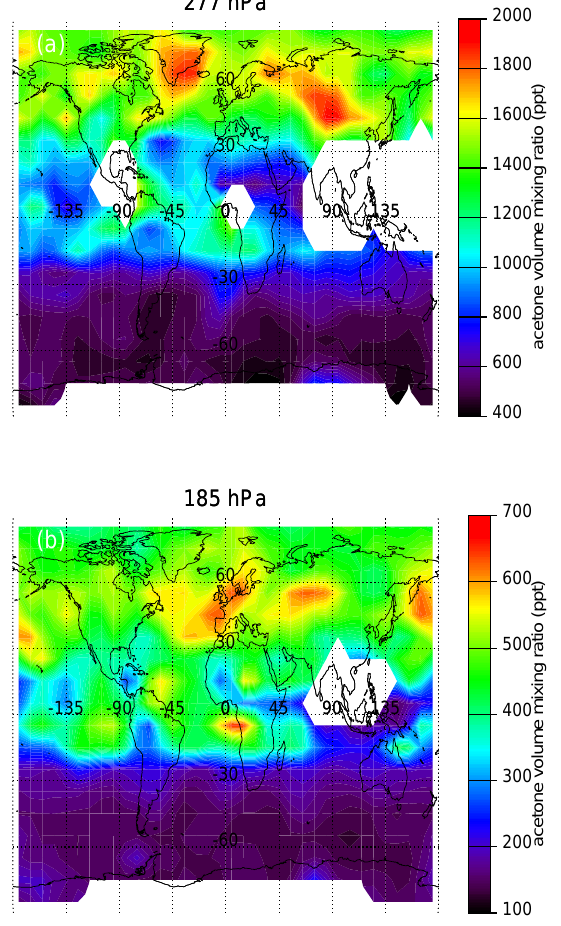
Fig. 7. Global acetone distributions (in units of pptv) at average pressure levels of (a) 277hPa and (b) 185hPa for the month of Au- gust 2003. White areas are regions where there are less than 5 data points for the month.